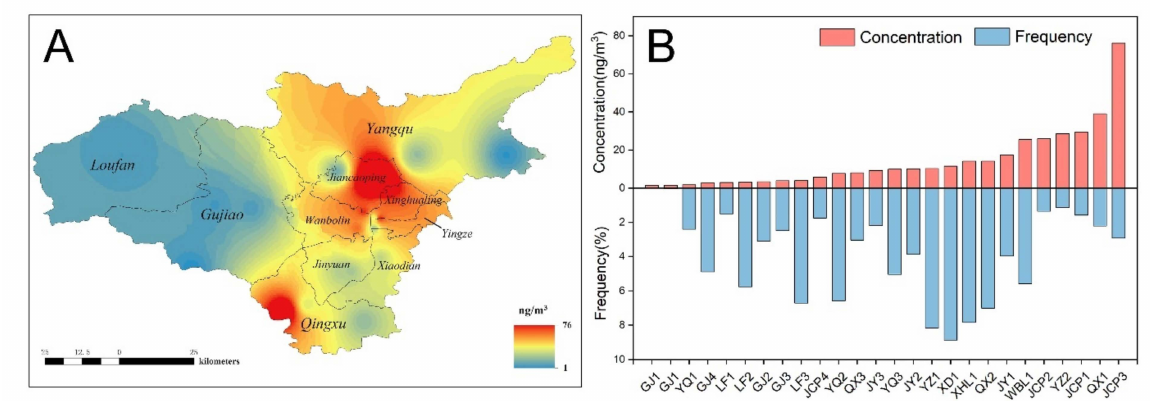
Figure 6. ( A ) Spatial distribution of BaP eq concentration in Taiyuan City and ( B ) participant frequency of each sampling